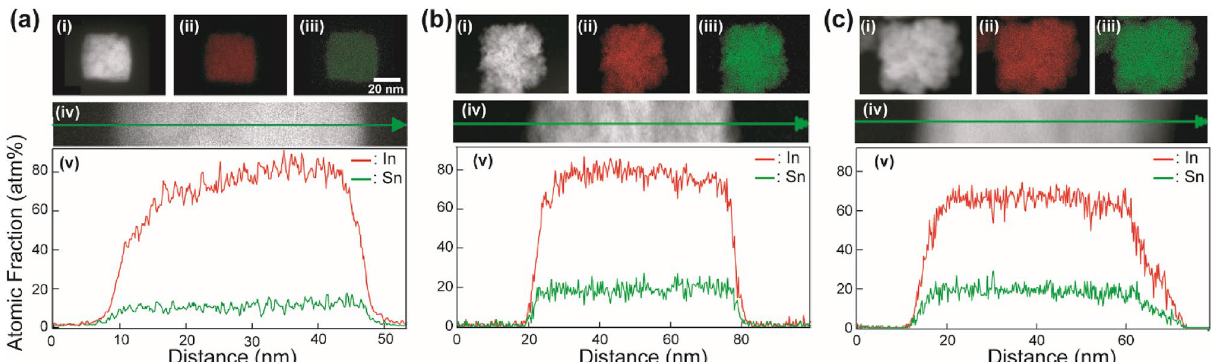
Figure 2. Results of (i) HAADF-STEM analysis of ( a ) C1 , ( b ) P1 , and (c) P2 . EDS mapping images ((ii) indium K α1 ; (iii) tin K α1 ) of the HAADF-STEM images shown in ( a ), ( b ), and ( c ). (iv) Images showing the positions of the line profiles for determining the distributions of In and Sn atoms in the NPs. (v) Line profiles of In and Sn atoms in the ITO NPs. The maximum intensity of 100 atom% is normalized to the point where the sum of the In and Sn intensities is the highest. The scale bar shown in ( a ) (iii) is common to